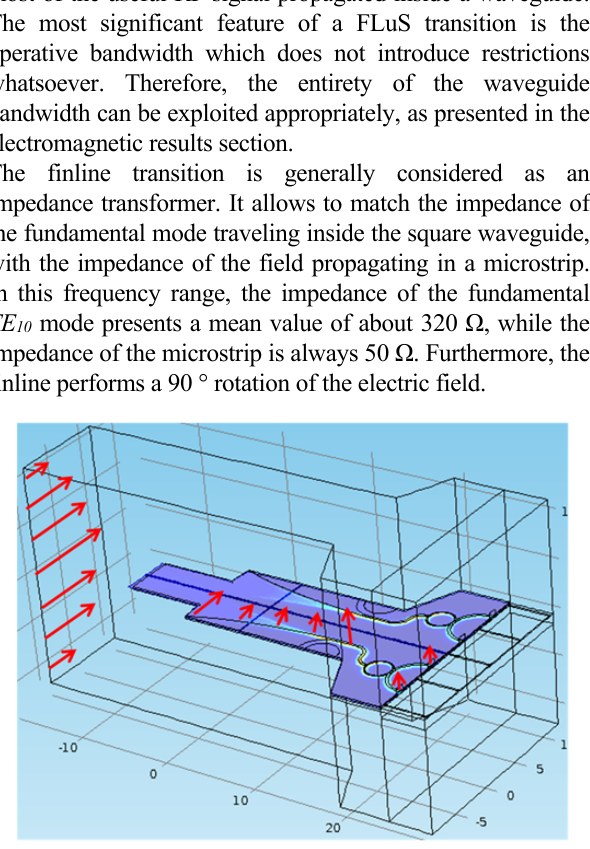
FIGURE 3. Electric Field Rotation performed by